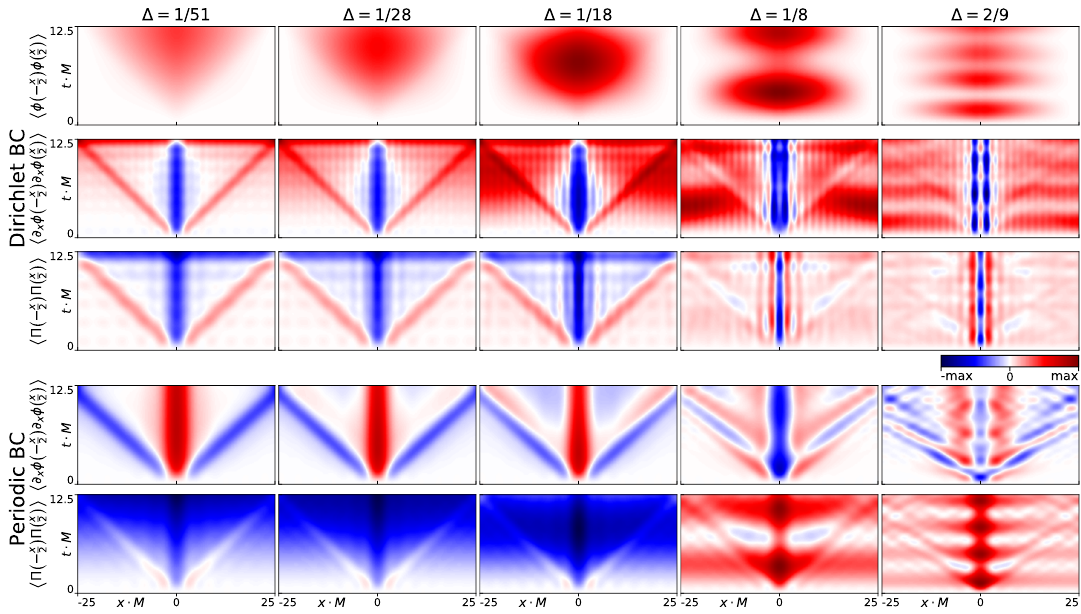
Figure 1 . Density plots of connected correlations of (cid:8), @ x (cid:8) and (cid:5) as functions of distance and time, obtained from TCSA simulation in a box with Dirichlet or periodic boundary conditions (DBC resp. PBC). The initial state is the KG ground state with mass m 0 in the DBC case or the SG ground state with (cid:12)rst breather mass of equal magnitude m 0 = 2 M 0 sin (cid:25) (cid:1) = (2 (cid:0) 2(cid:1)) for PBC. The dynamics corresponds to SG with soliton mass M = 2 : 5 m 0 and increasing values of the coupling parameter (cid:1) = (cid:12) 2 = 8 (cid:25) . Initial correlations have been subtracted from the result, and the box length is L = 10 m (cid:0) 1 0